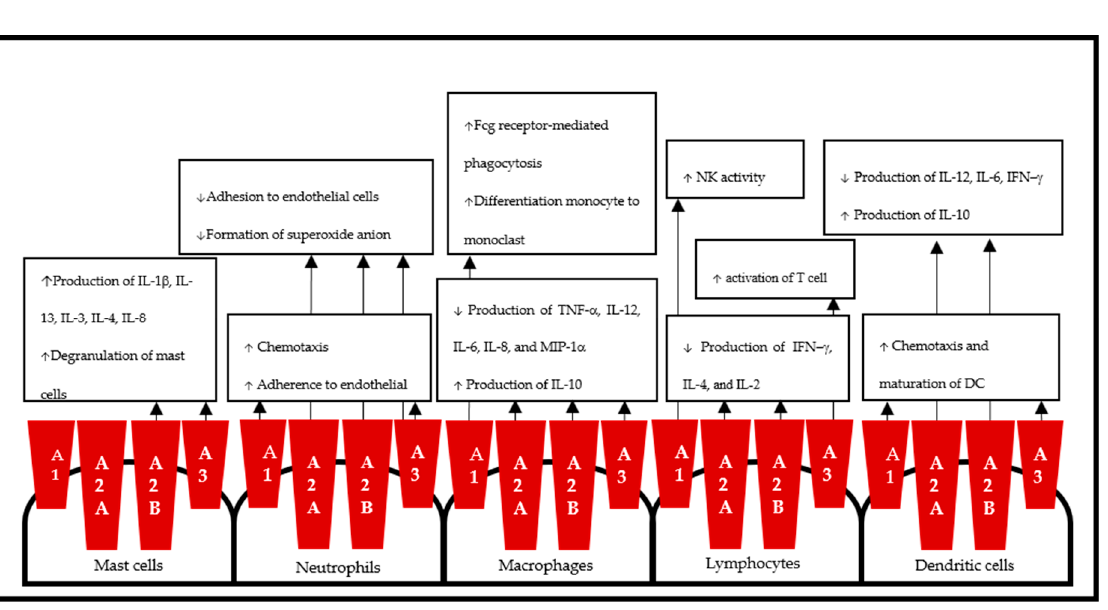
Figure 2. Schematic representation of adenosine receptors in immune cells. Adenosine receptors carry out the proinflammatory and anti-inflammatory effects of adenosine through predominant immune cells: macrophages, neutrophils, mast cells, lymphocytes, and dendritic cells.